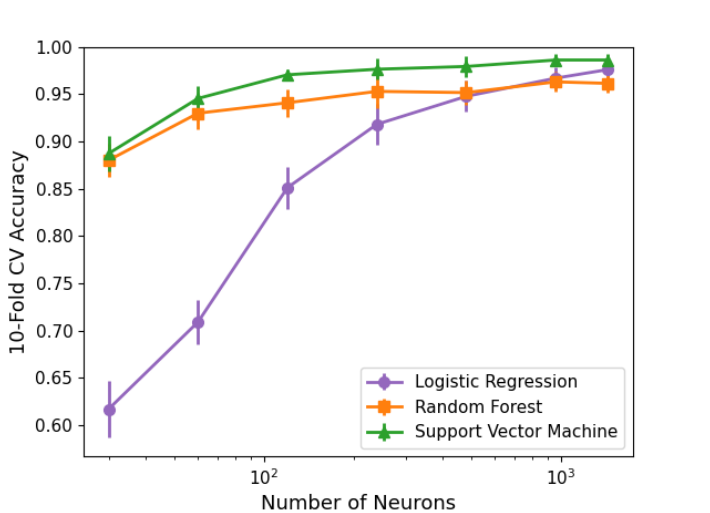
Figure 15. The 10-fold cross-validation accuracy vs. LSM size for all three classifiers. The error bars indicate the standard deviation. It shows the best results irrespective of C inp